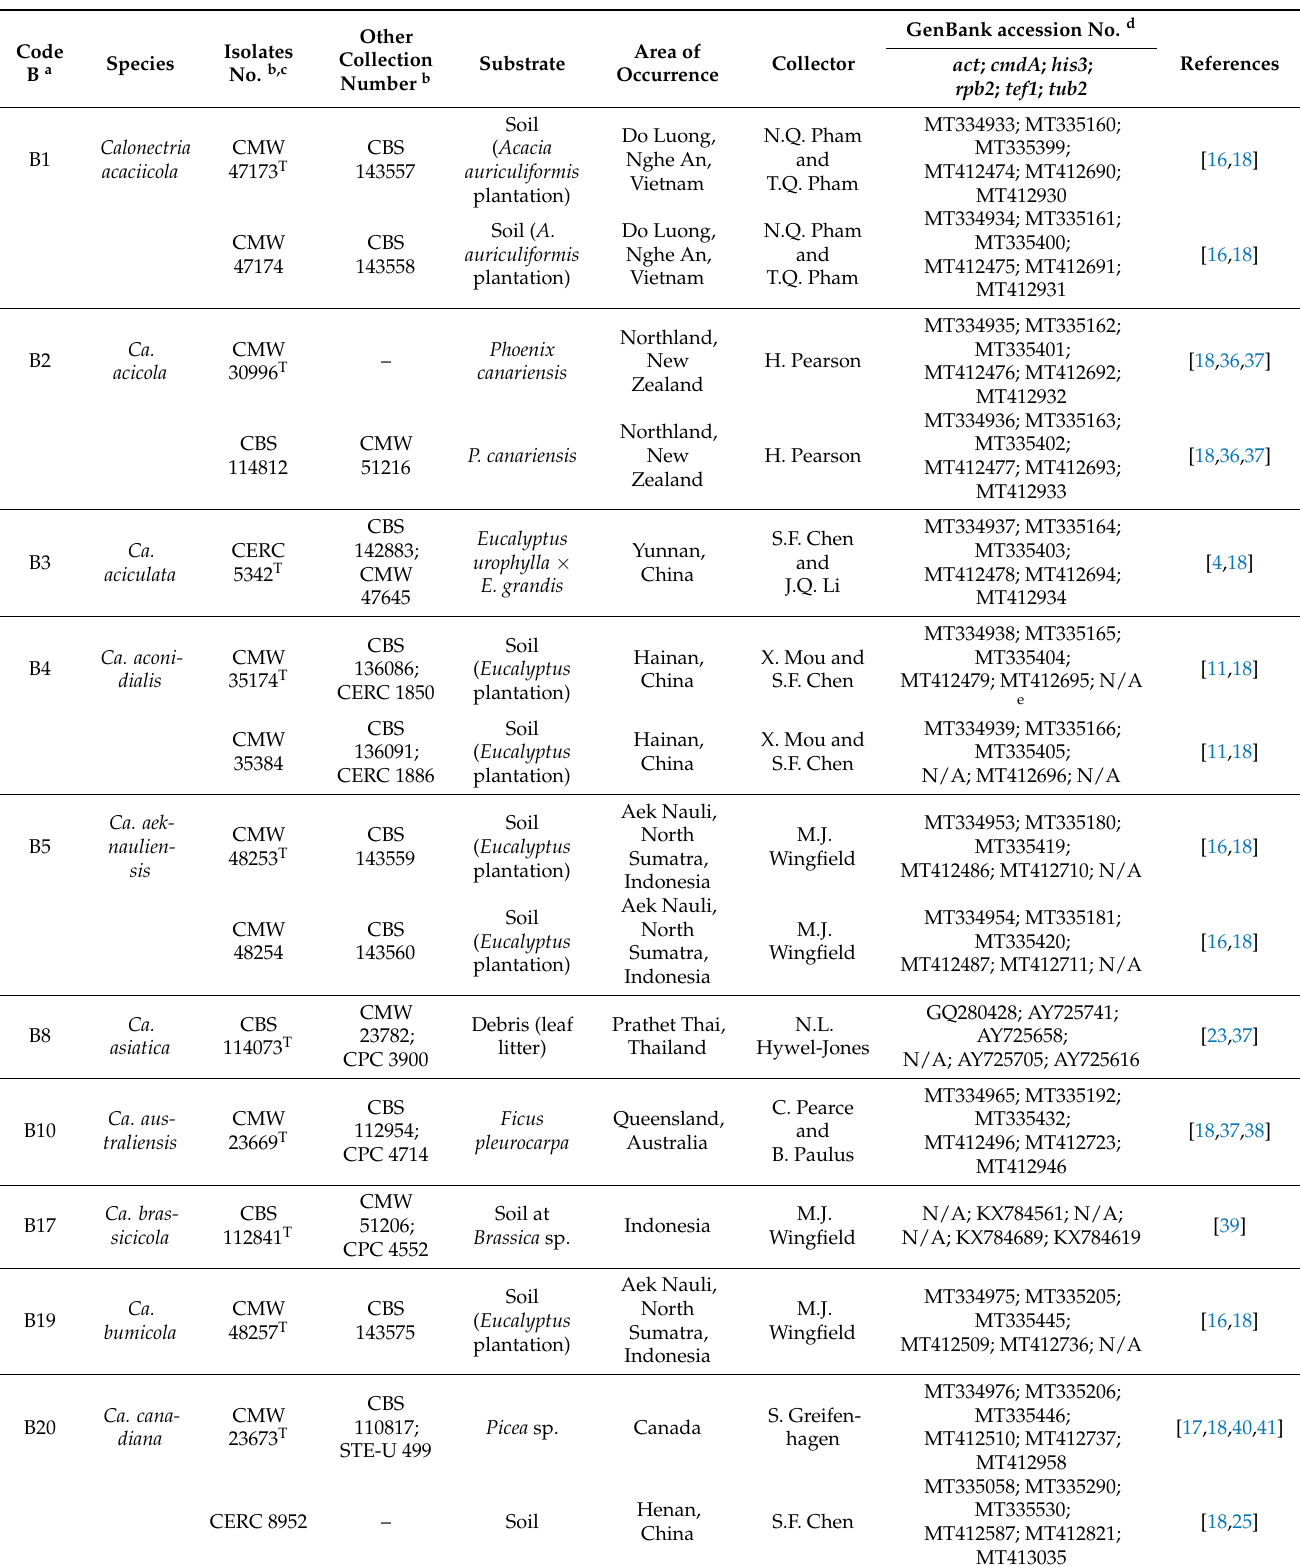
Table 3. Isolates from other studies and used in the phylogenetic